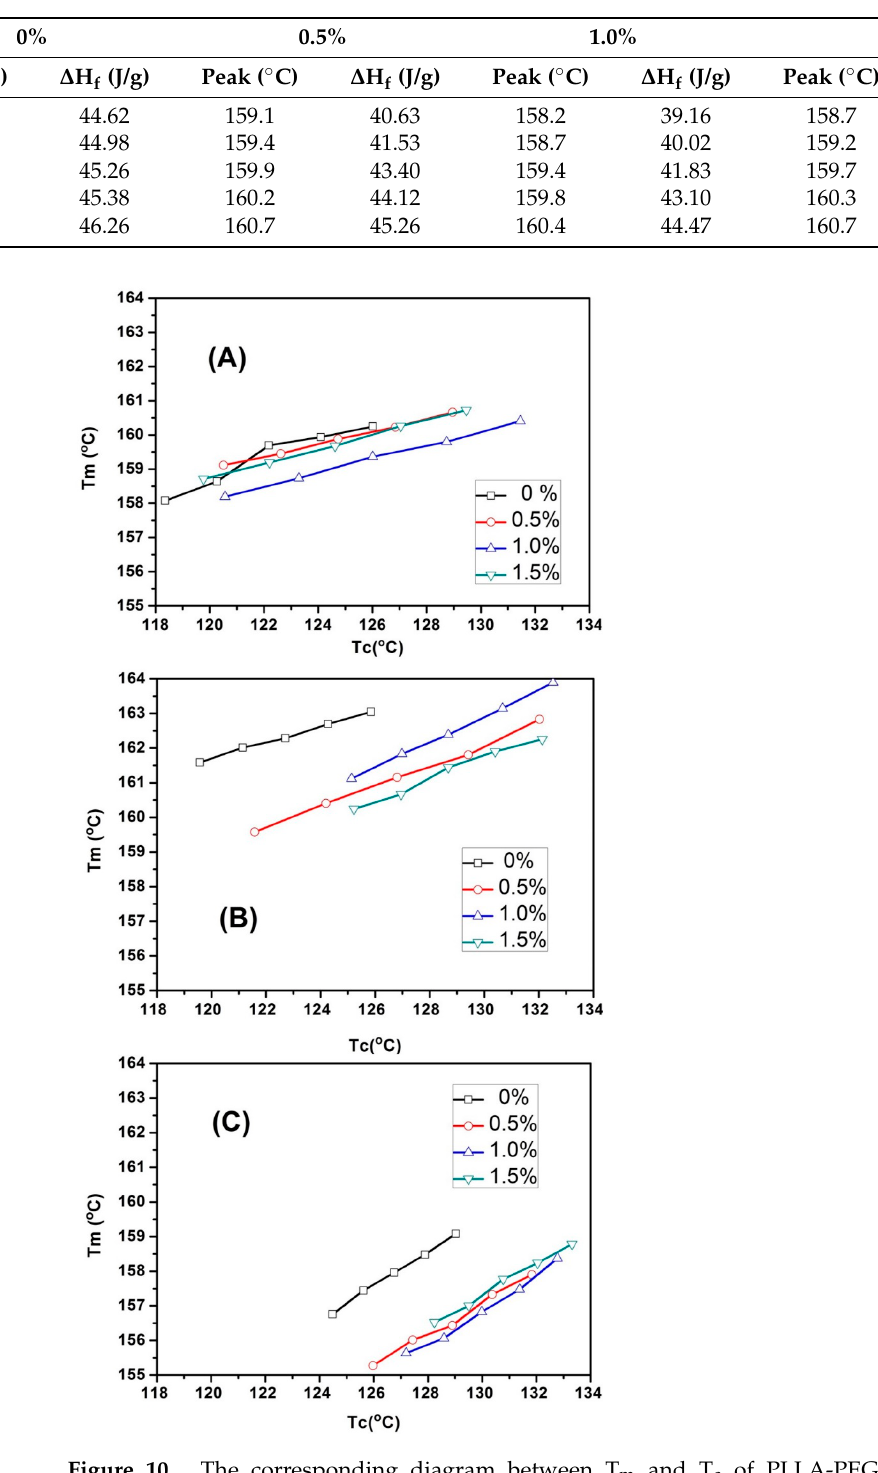
Figure 10. The corresponding diagram between T m and T c of PLLA-PEG copolymer and PLLA-PEG/o-MMT nanocomposites. ( A ) PLLA-PEG200, ( B ) PLLA-PEG1000, and ( C ) PLLA-PEG2000 copolymer.